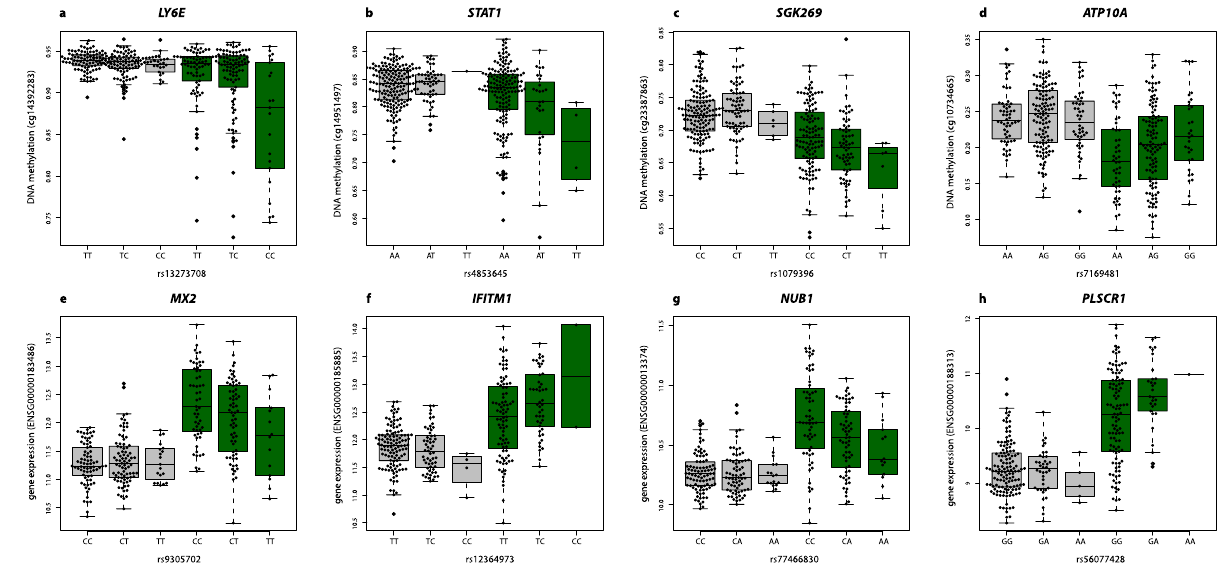
Figure 5. Disease interacting QTLs (a ) The minor C-allele of SNP rs13273708 is associated with a decrease in DNA methylation levels at LY6E gene only in SS patients (ß SS.meQTL = − 0.018, P SS.meQTL = 6 × 10 –04 ), but not in the healthy population (P SS.meQTL > 0.05). ( b ) The minor A-allele of SNP rs902834 decreases the DNA methylation level at STAT1 only in SS patients (ß SS.meQTL = − 0.024, P SS.meQTL = 0.0012), and not the healthy population (P CTRL.meQTL > 0.05). ( c ) The minor T-allele of rs1079396 is associated with SGK269 -methylation in SS patients (ß SS.meQTL = -0.017, P SS.meQTL = 0.0119), but not in the healthy population (P CTRL.meQTL > 0.05). ( d ) The minor G-allele of rs7169481 in ATP10A is associated with increased DNA methylation at ATP10A in SS patients (ß SS.meQTL = 0.018, P SS.meQTL = 0.0047). However, in the healthy population this allele has no significant effect (P CTRL.meQTL > 0.05). ( e ) The minor T-allele of the rs9305702 genetic variant is associated with a decreased MX2 gene expression in SS patients (ß SS.eQTL = − 0.302, P SS.eQTL = 1.8 × 10 –04 ), and shows no evidence of association in the healthy population (P CTRL.eQTL > 0.05). ( f ) The minor C-allele of rs12364973 is associated with an increased IFITM1 gene expression in SS patients (ß SS.eQTL = 0.28, P SS.eQTL = 0.012) and shows no evidence of association in the healthy population (P CTRL.eQTL > 0.05). ( g ) In SS patients, NUBI expression decreases with the dose of the minor A-allele of rs77466830 (ß SS.eQTL = − 0.15, P SS.eQTL = 3.5 × 10 –04 ); however, in the healthy population it remains stable (P CTRL.eQTL > 0.05). ( h ) In SS patients, PLSCR1 expression increased with the dose of the minor A-allele of rs56077428 (ß SS.eQTL = 0.357, P SS.eQTL = 0.0208); however, in the healthy population it remains stable (P CTRL.eQTL > 0.05). Green boxplots represent SS population, while grey boxplots represent the healthy control population. DNA methylation is quantified with β-values, gene expression is at the logarithmic scale.